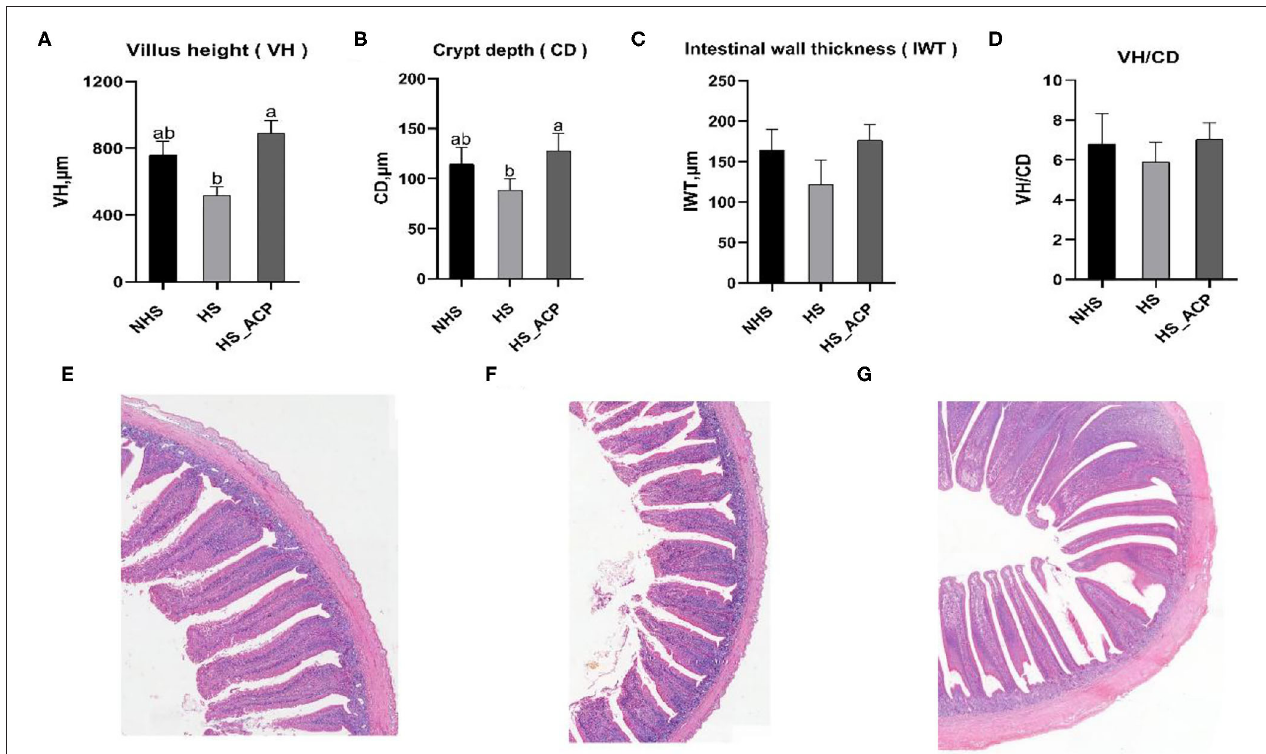
FIGURE 5 | Effects of ACP supplementation on the ileum histomorphology of the heat-stressed broilers. (A) Villus height (VH), (B) Crypt depth (CD), (C) Intestinal wall thickness (IWT), (D) VH: CD, (E) Ileum tissue section of the NHS group, (F) Ileum tissue section of the HS group, and (G) Ileum tissue section of the high temperature model group with ACP dose HS_ACP group. The effect of the treatment was statistically different at p < 0.05. Different letters indicate the significant difference between